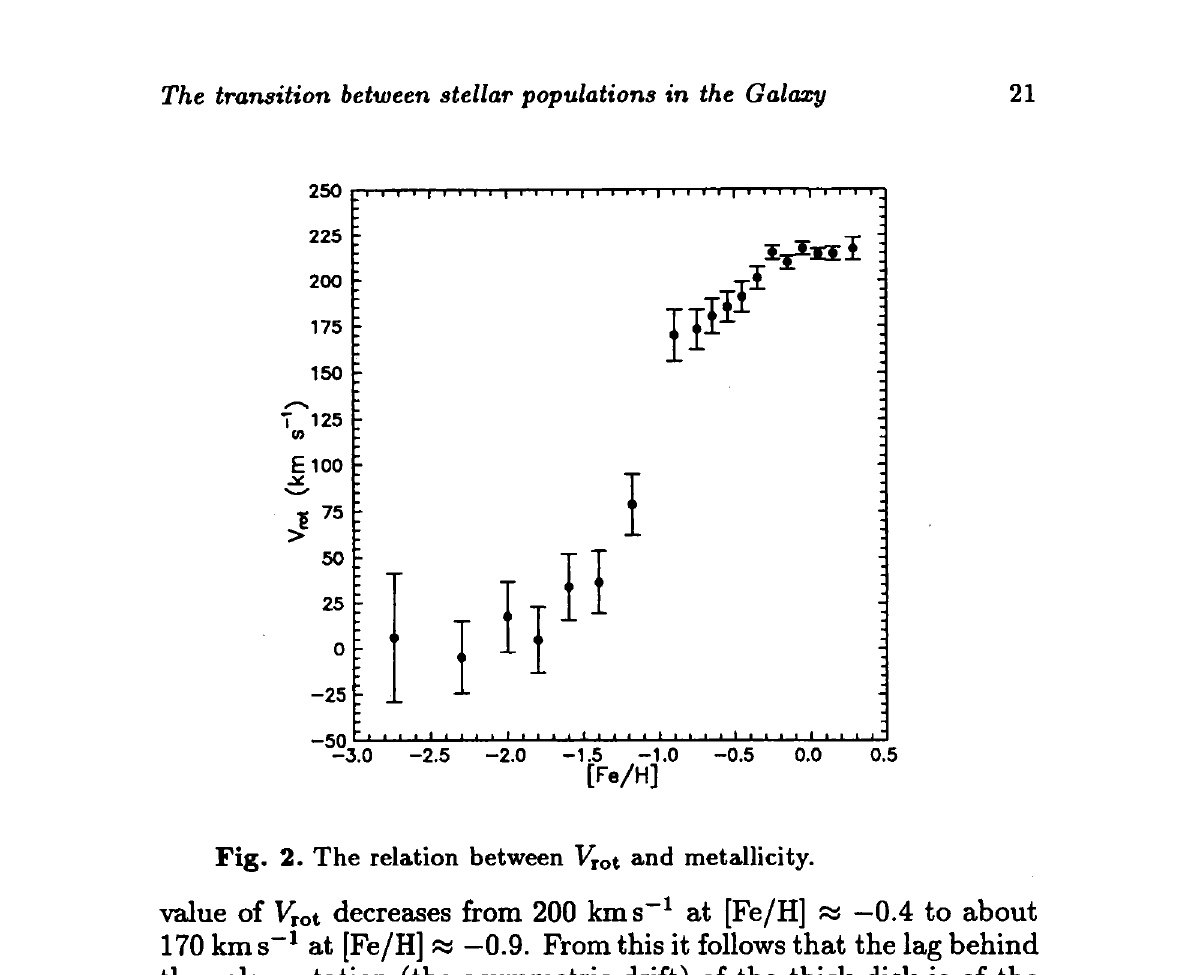
Fig. 2. The relation between V^